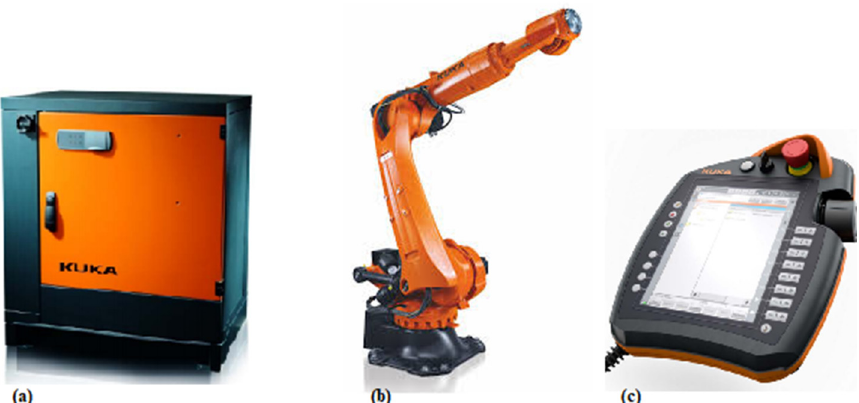
Figure 1. ( a ) Control unit; ( b ) KUKA TM robot; ( c ) SmartPAD.